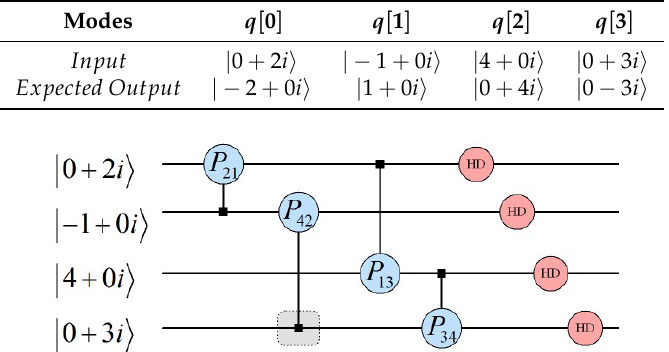
Figure 4. Design schematic on the CPCOs with four input ports whose values are | 0 + 2 i (cid:105) , | − 1 + 0 i (cid:105) , | 4 + 0 i (cid:105) and | 0 + 3 i (cid:105) respectively. P hk represents the PCO where the h -th coherent state controls the k -th coherent state. Square dots (cid:4) in the gray virtual box represents multiple judgement conditions referred to Equation (2). "HD" in the red box is the heterodyne detection